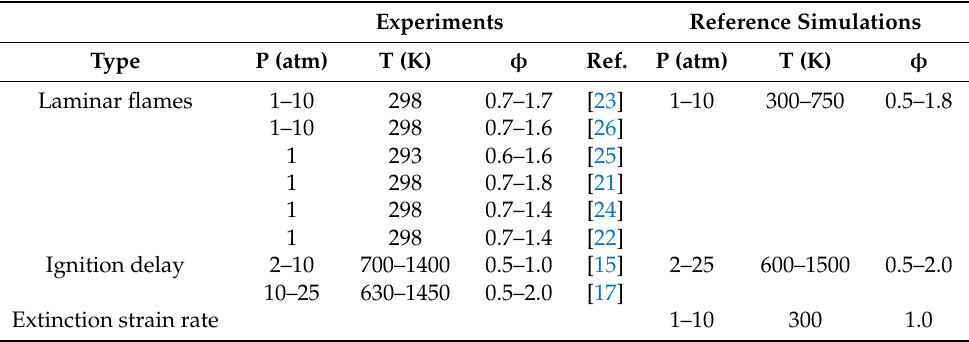
Table 2. Summary of experimental data and modelling performed using the reference mechanisms in their respective